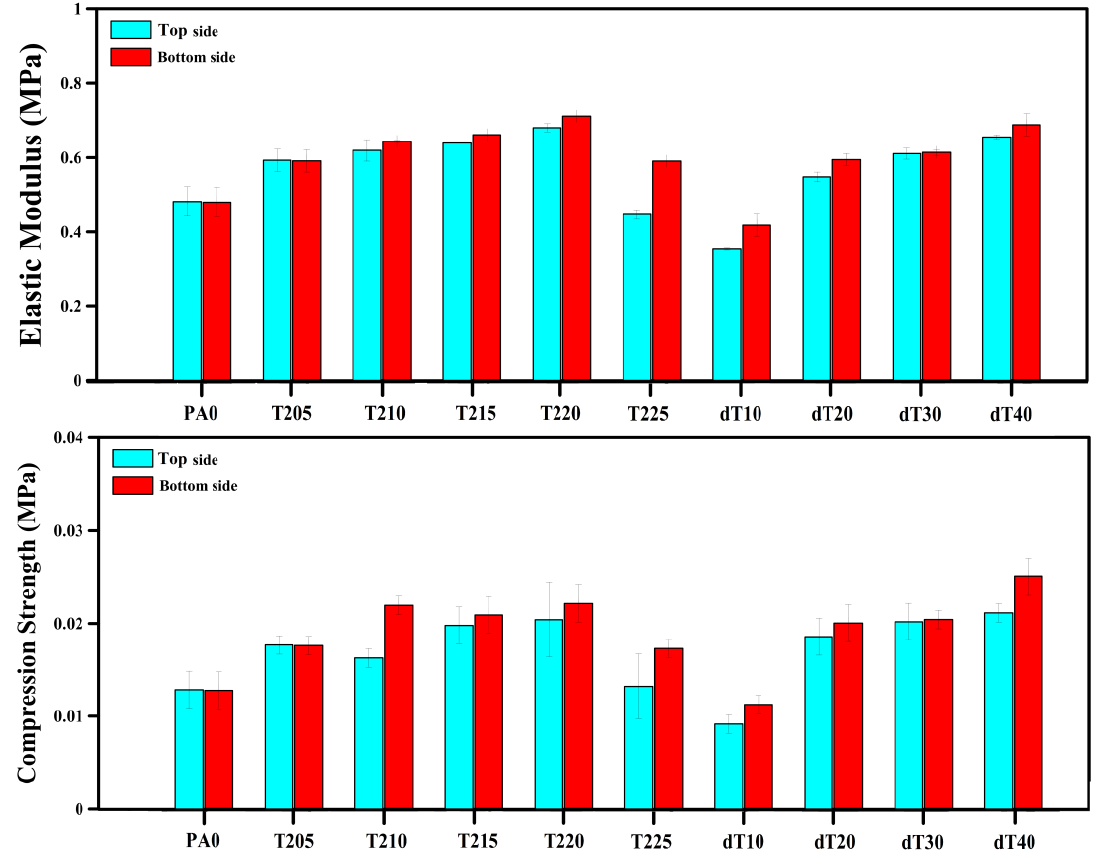
Figure 3. Elastic modulus and compression strength (at 7% compression) of the unfoamed, uniform and graded POE foams.